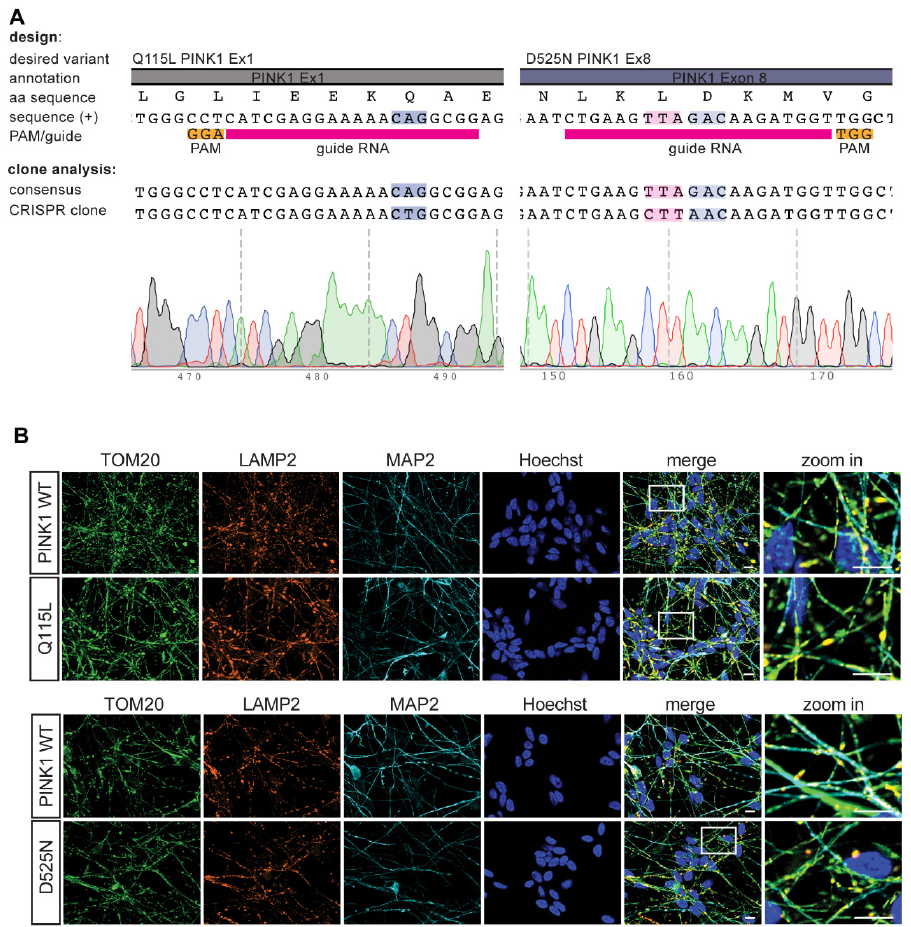
Figure 6. Gene-editing of PINK1 variants in mid-brain derived neuronal precursor cells. ( A ) Details for gene-editing of PINK1 WT to Q115L or D525N using CRISPR/Cas9 is shown from top to bottom with exon/intron structure, amino acid sequence, genomic sequence, guideRNA and PAM sequence, as well as results from Sanger sequencing of positive cell clones. Blue highlight indicates targeted triplet for intended amino acid change, pink highlight shows position of a silent mutation that was introduced to block re-editing and facilitate screening by restriction enzyme digest. ( B ) Mid-brain derived precursors were differentiated to neurons, fixed, stained and analyzed by immunofluorescence. Cells were stained with antibodies against TOM20 (mitochondria, green), LAMP2 (lysosomes, red) and MAP2 (neuronal marker, cyan). Nuclei were counterstained with Hoechst (blue). A zoom into the indicated region is shown to the right. Scale bars indicate 10 µm. We transfected ReNcell VM with guideRNA, a plasmid expressing GFP-tagged Cas9, and repair template by nucleofection, purified the cells by flow cytometry to sort GFP- positive cells, and seeded them into 96-well plates to grow as single clones. Screening was about 150 clones per intended mutation but received only one clone for Q115L and eight